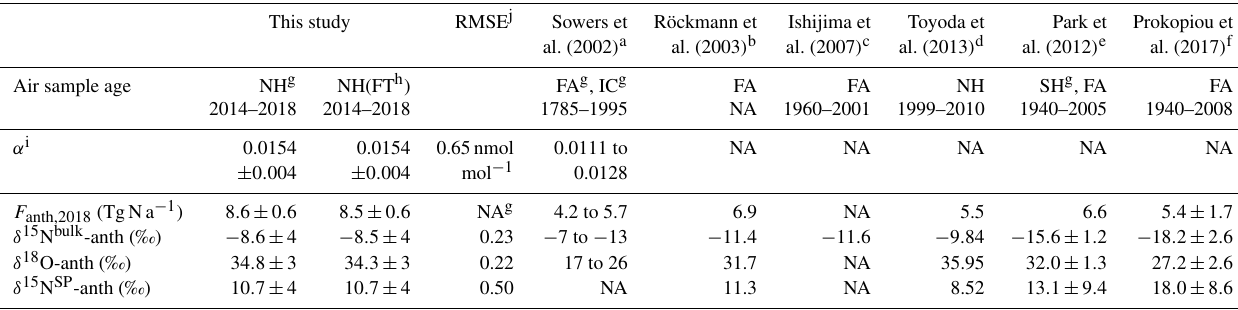
Table 4. Results of the two-box model simulations and selected literature values for